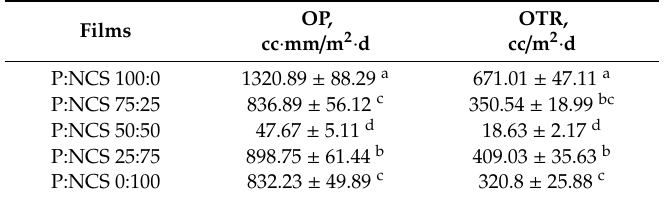
Table 5. Oxygen permeability (OP) and oxygen transmission rate (OTR).